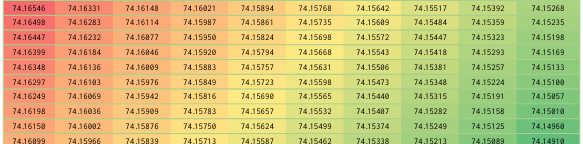
Table 7. Slopes of the fitting straight lines on the left image of the GeoEye dataset (degree)